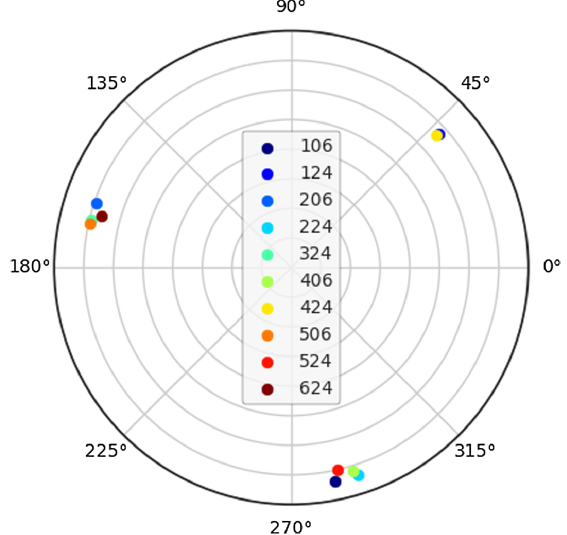
FIG. 7. Phase and amplitude of the resonance (sextupole) driving terms for each of the SPS extraction sextupoles (LSE): the naming reflects the sextant in which they are located and the quadrupole next to which they are installed, e.g., 424 is adjacent to the 24th quadrupole in sextant 4. The four LSE sextupoles used in regular operation are grouped at a relative phase close to 290 deg.